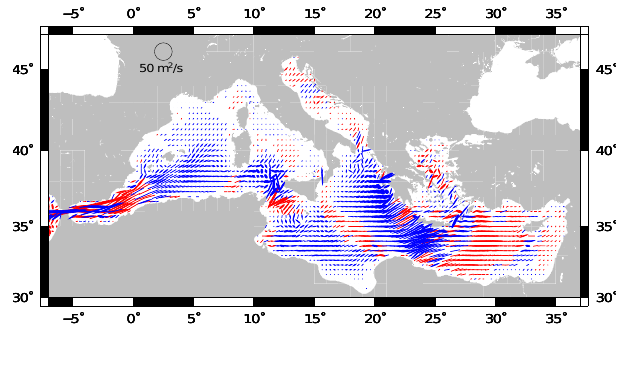
Fig. 14. Transport ellipses of S2 constituent. Red = clockwise, blue = anticlockwise